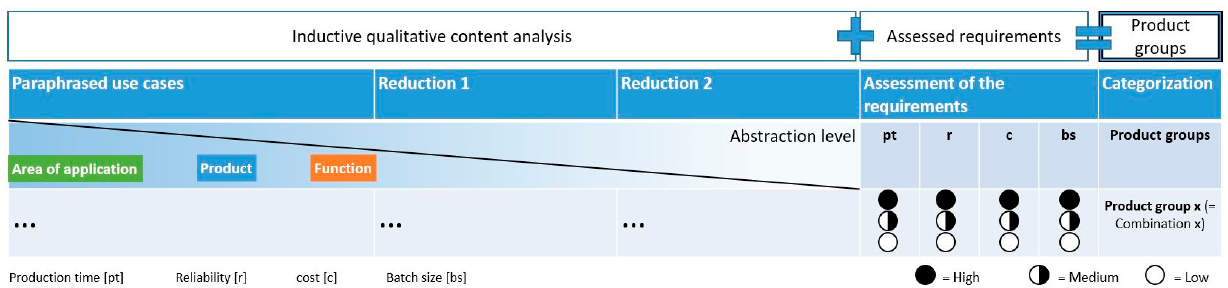
Figure 5. Overview of the soft tooling components that are printed with digital light processing (DLP): ( a ) ejector mold; ( b ) cavity; ( c ) injection mold; ( d ) slides M18 and M14. The project was carried out in co ‐ operation with a company that develops and dis ‐ tributes high ‐ quality connectors worldwide. The goal is to develop and produce an intel ‐ ligent electrical connector with contacts on the input side and a substrate that was cus ‐ tomer ‐ specifically and individually developed. The idea and aim are to produce rapidly for early customers who can then provide feedback for serial production. In order to be able to validate the feasibility of series production at an early stage, it makes sense not to print the component directly (rapid prototyping or direct manufacturing) but to use an additively manufactured tool insert (soft tooling). That way, the injection ‐ molding process can be validated, and failure costs in the subsequent production of steel tools can be avoided (see Figure 6).